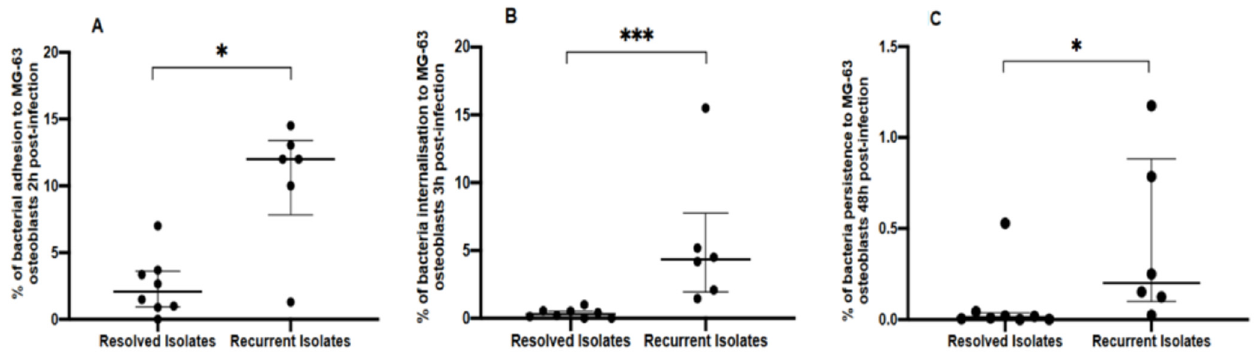
Figure 1. Adhesion ( A ), invasion ( B ) and persistence intracellular assay ( C ) on MG63 osteoblasts of PJI S. aureus isolates. All results are expressed as the percentage of the initial strain ( ≈ 5 × 10 6 ). The horizontal bars denote the median with the interquartile range derived from three independent experiments in triplicate for each clinical isolate. Statistical analysis were performed by using the Mann–Whitney U-test (* p < 0.05; *** p < 0.001.